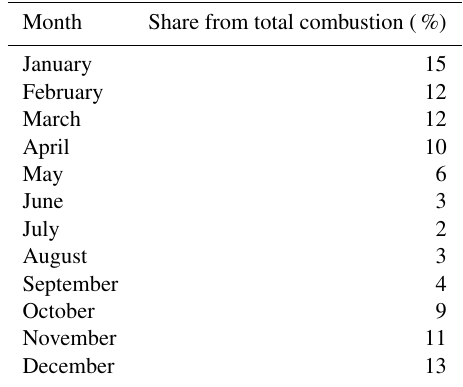
Table A5. Share of total yearly combustion during each month used in emission